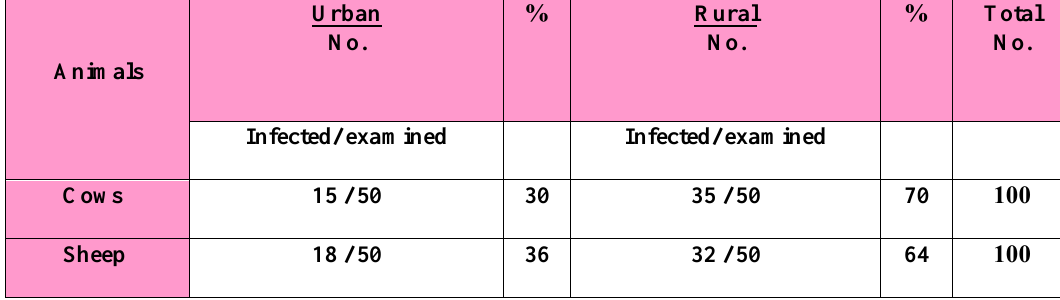
Table(2):The incidence and distribution of dermatophytes infection in Cows and sheep according to their location.